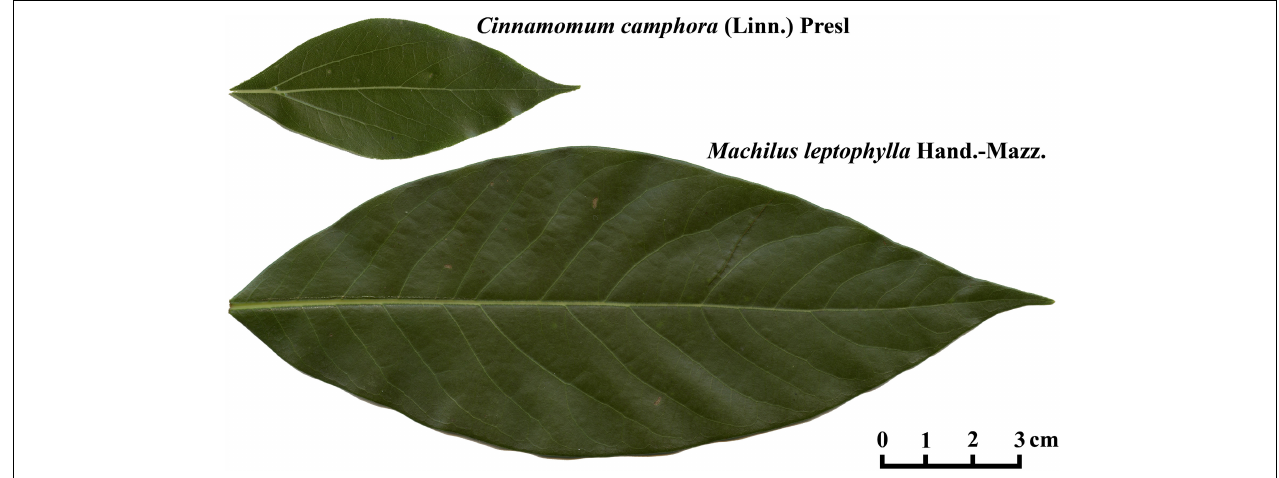
FIGURE 2 | Leaf examples of Cinnamomum camphora (L.) Presl and Machilus leptophylla Hand.-Mazz. (Lauraceae).